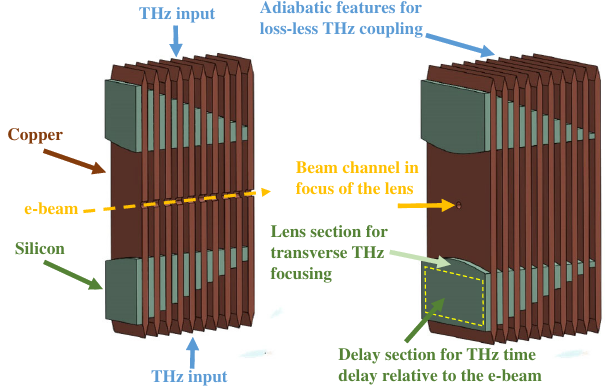
FIG. 9. Sketch of a multicell broadband accelerating structure based on dielectric delay sections and lenses.